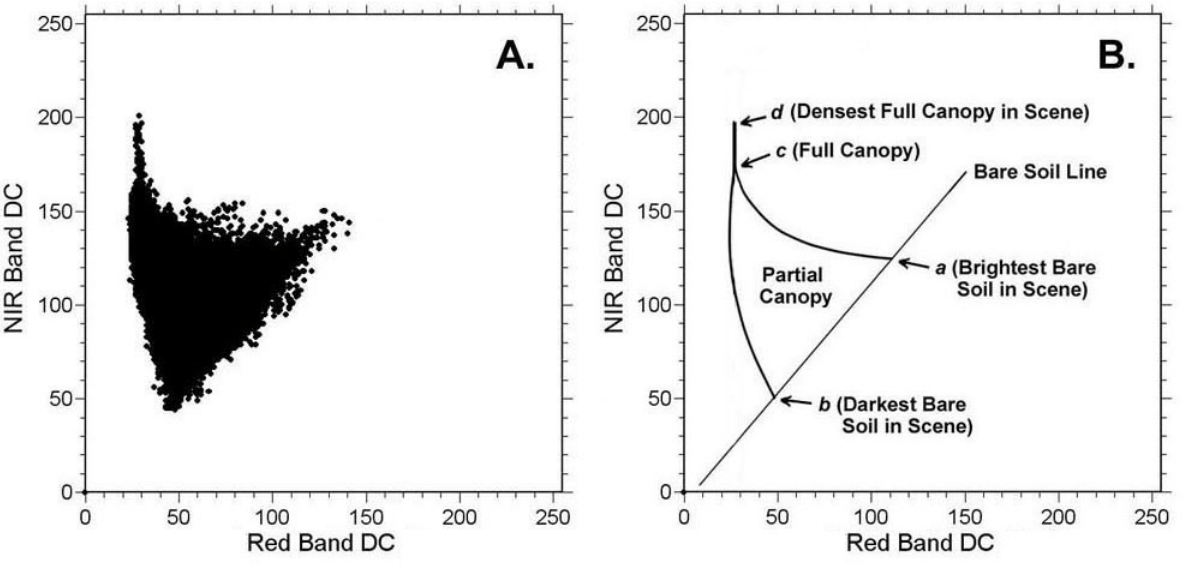
Figure 1. Red-NIR scatter plot of pixel DC values for a portion of a cloud-free Landsat-5 image of an agricultural region. (A) Actual distribution of DC values. (B) Diagrammatic representation of features of the scatter plot of DC